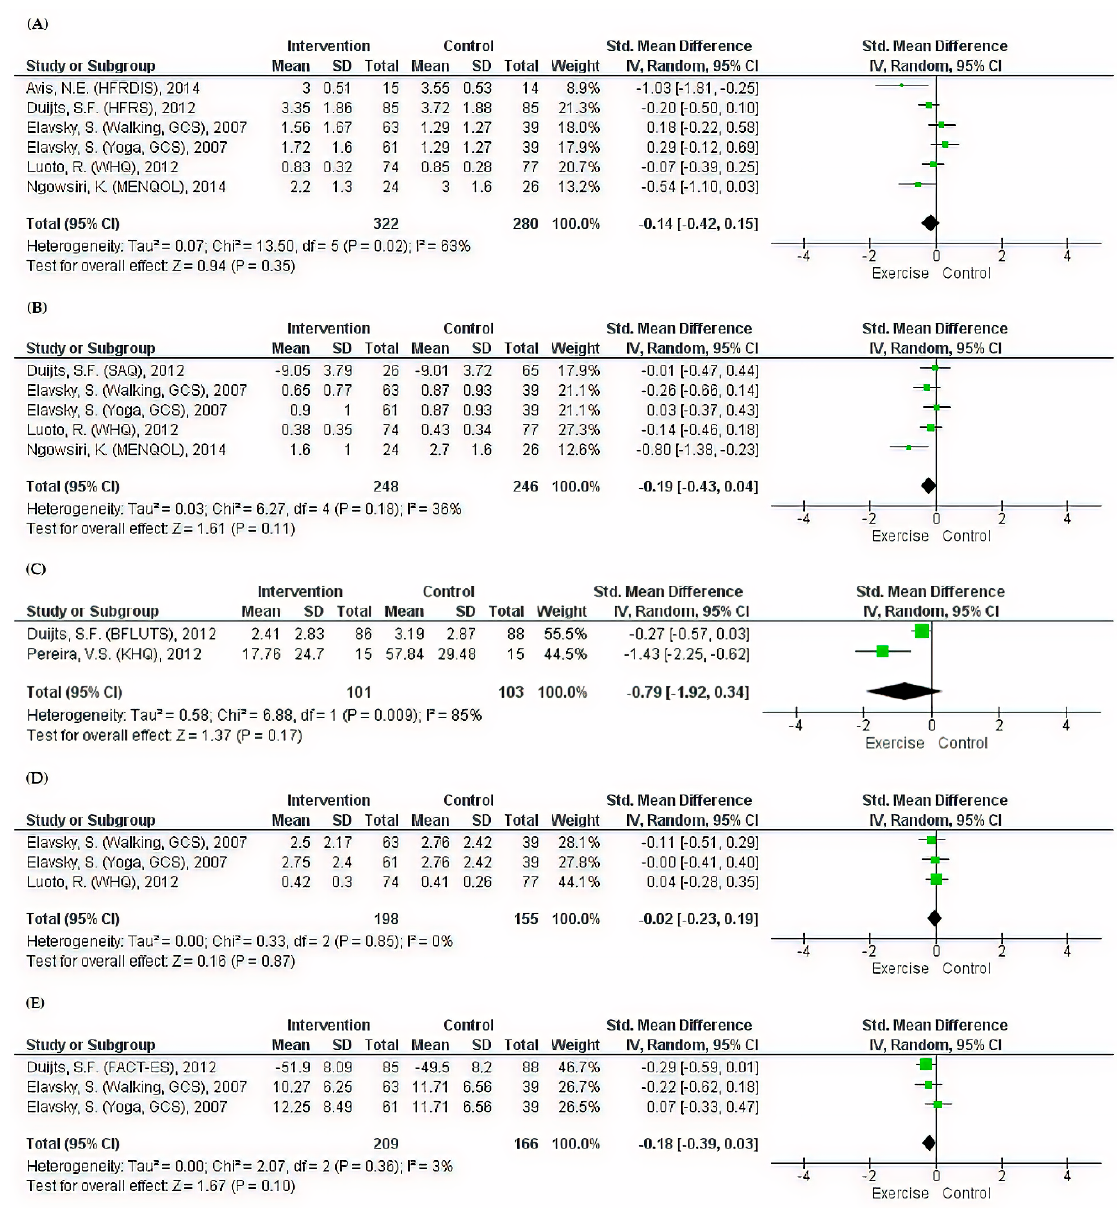
Figure 3. Meta-analyses of the e ff ects of exercise on menopause-specific QoL domains. ( A ) Forest plot of six datasets on vasomotor symptoms. ( B ) Forest plot of five datasets on sexual symptoms. ( C ) Forest plot of two datasets on urinary symptoms. ( D ) Forest plot of three datasets on somatic symptoms. ( E ) Forest plot of three datasets on total symptoms.